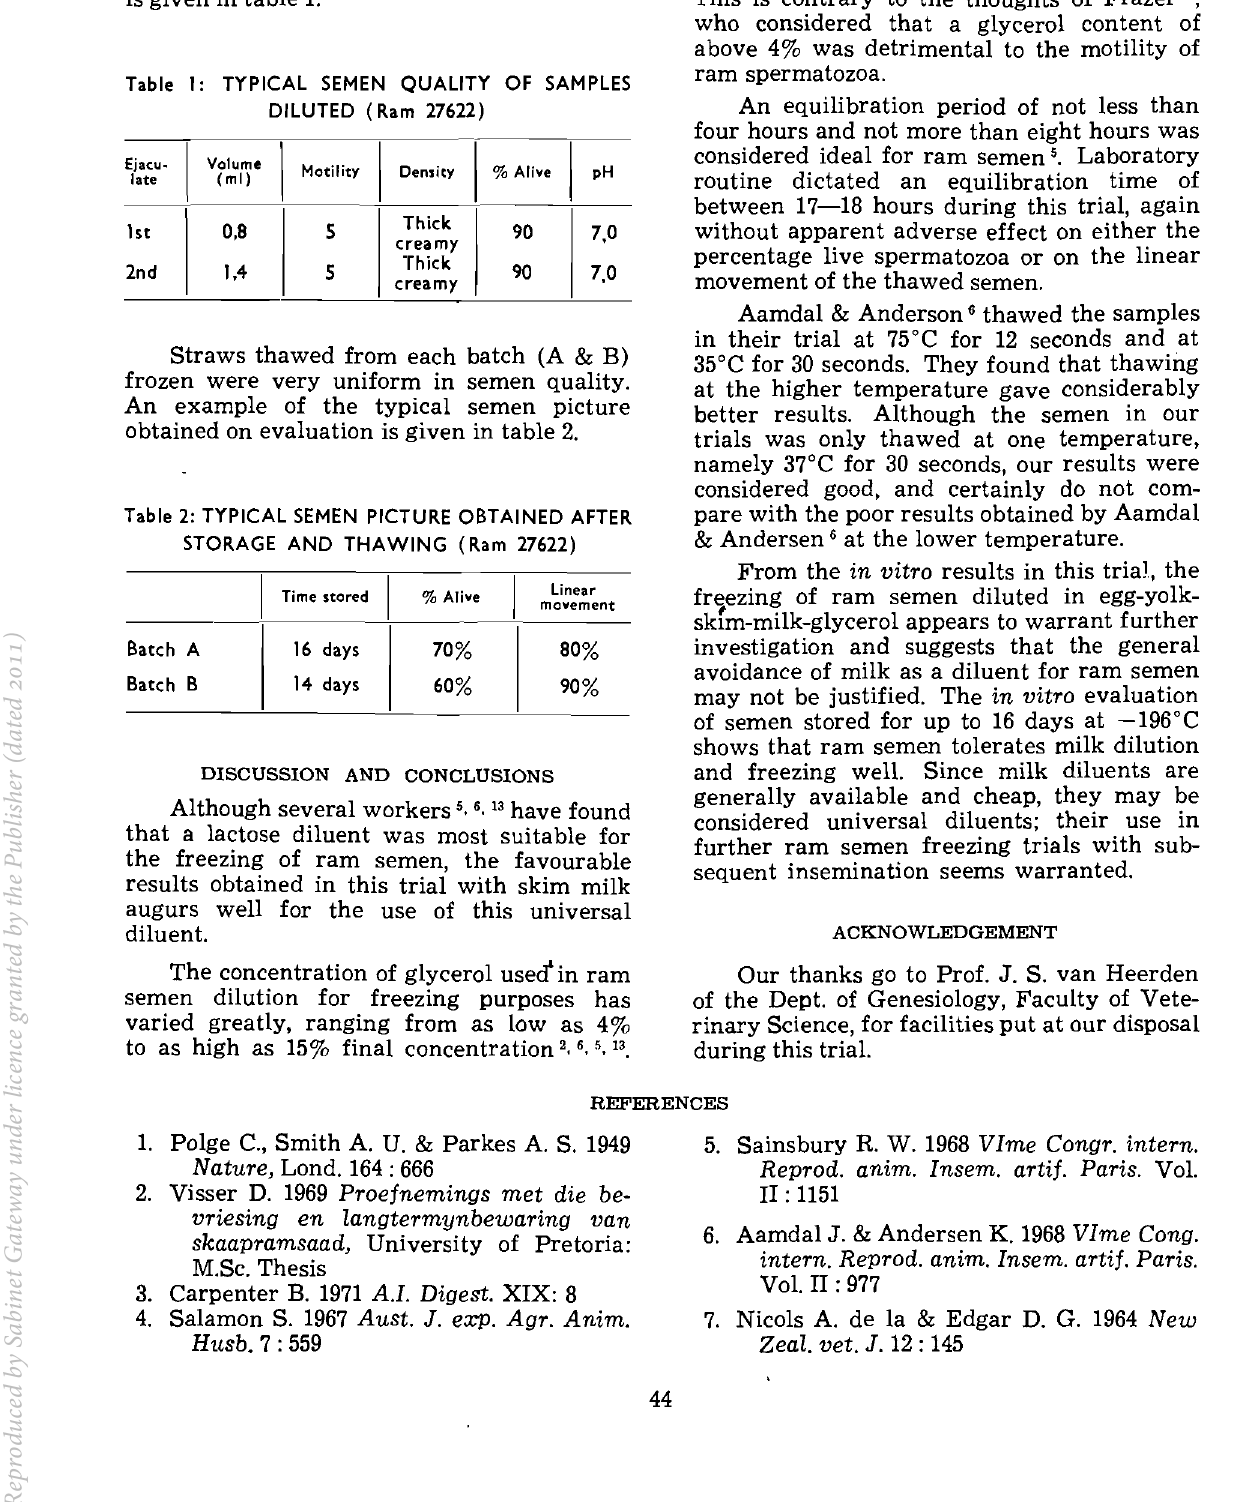
Table 2: TYPICAL SEMEN PICTURE OBTAINED AFTER STORAGE AND THAWING (Ram